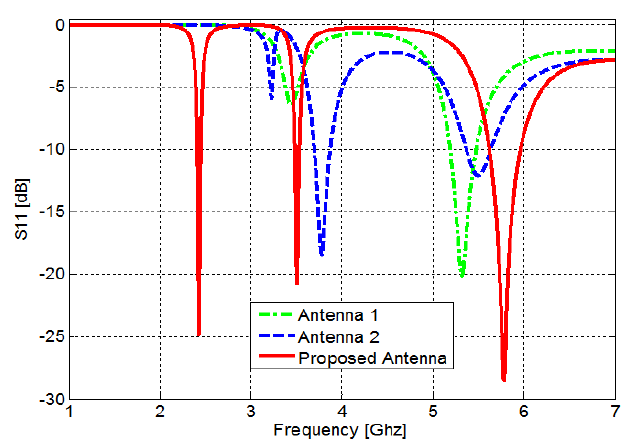
Figure 3: Return losses versus frequency of various ACS- fed antenna structures